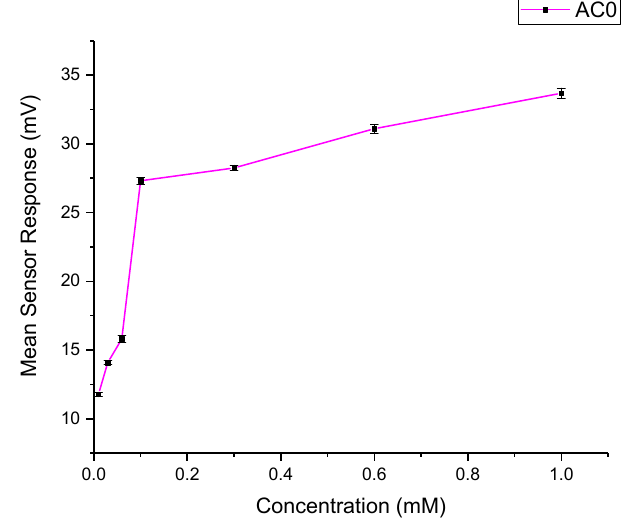
Figure 8. AC0 sensor response for PSP as a function of concentration.